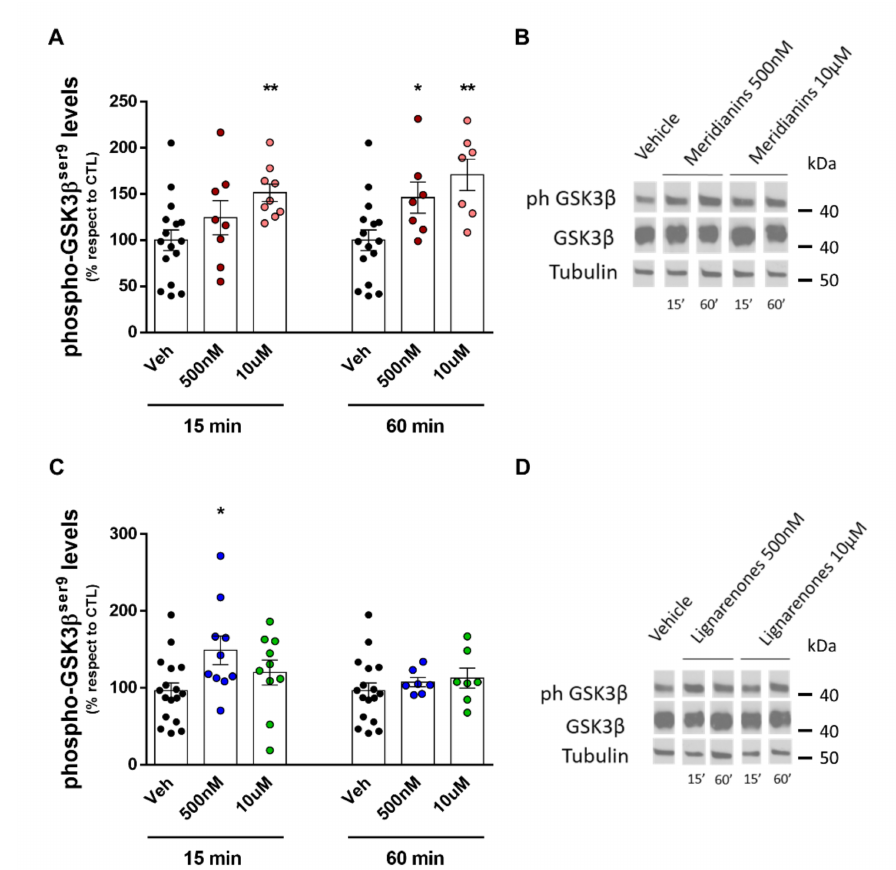
Figure 6. Increased GSK3 β phosphorylation at Ser9 residue by meridianins and lignarenone B. Densitometric quantification of pGSK3 β ( A ) and total GSK3 β in cortical primary cultures treated with meridianins (500 nM or 10 µ M) or vehicle, for 15 and 60 minutes. Protein levels were